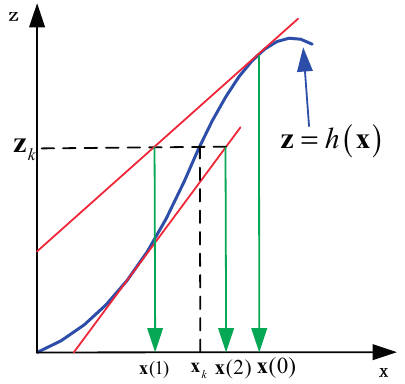
Figure 5. Graphic fundamental of IEKF with two